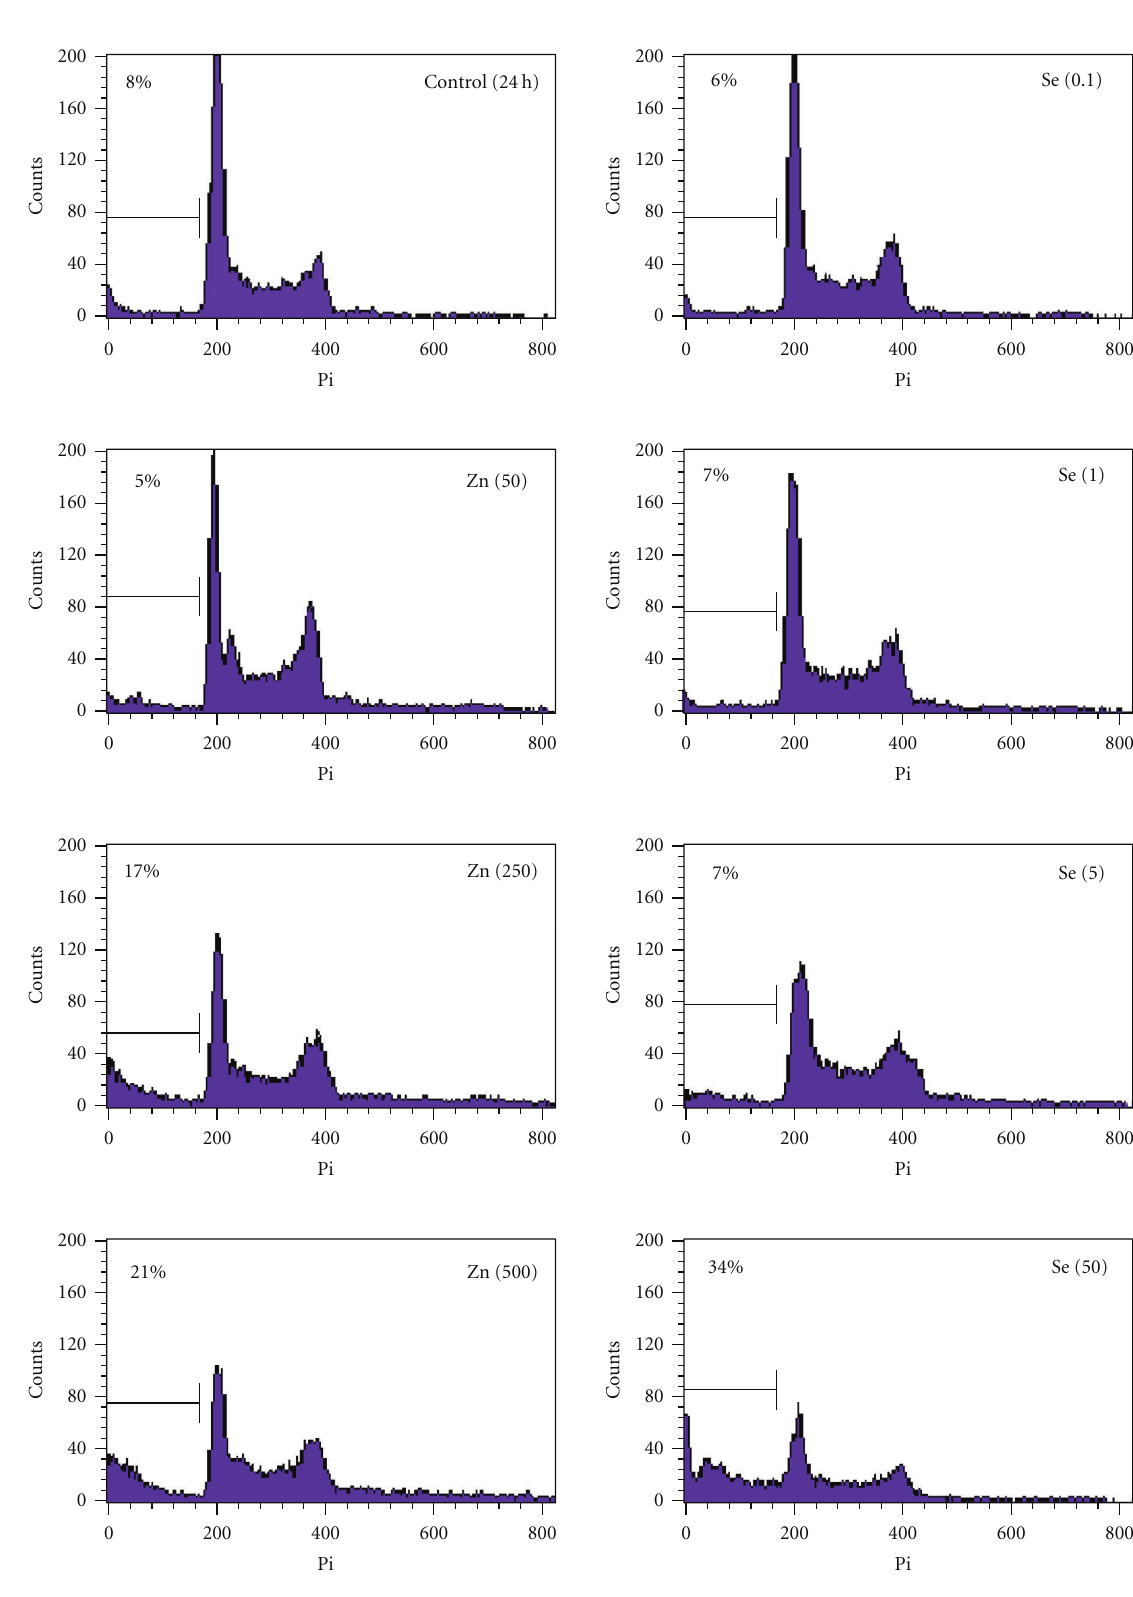
Figure 2: Induction of apoptosis in AS-30D cells by di ff erent concentrations of Zn 2+ and selenite. The cells were cultivated in RPMI 1640 medium without (control) or with the indicated concentration (in µ M) of Zn 2+ and selenite for 24 h, stained with propidium iodide, and analysed by flow cytometry. Percentage of the sub-G 1 fraction, characteristic for apoptotic cells, is indicated in the upper left corner of each panel. A typical experiment out of at least three independent ones for each compound is